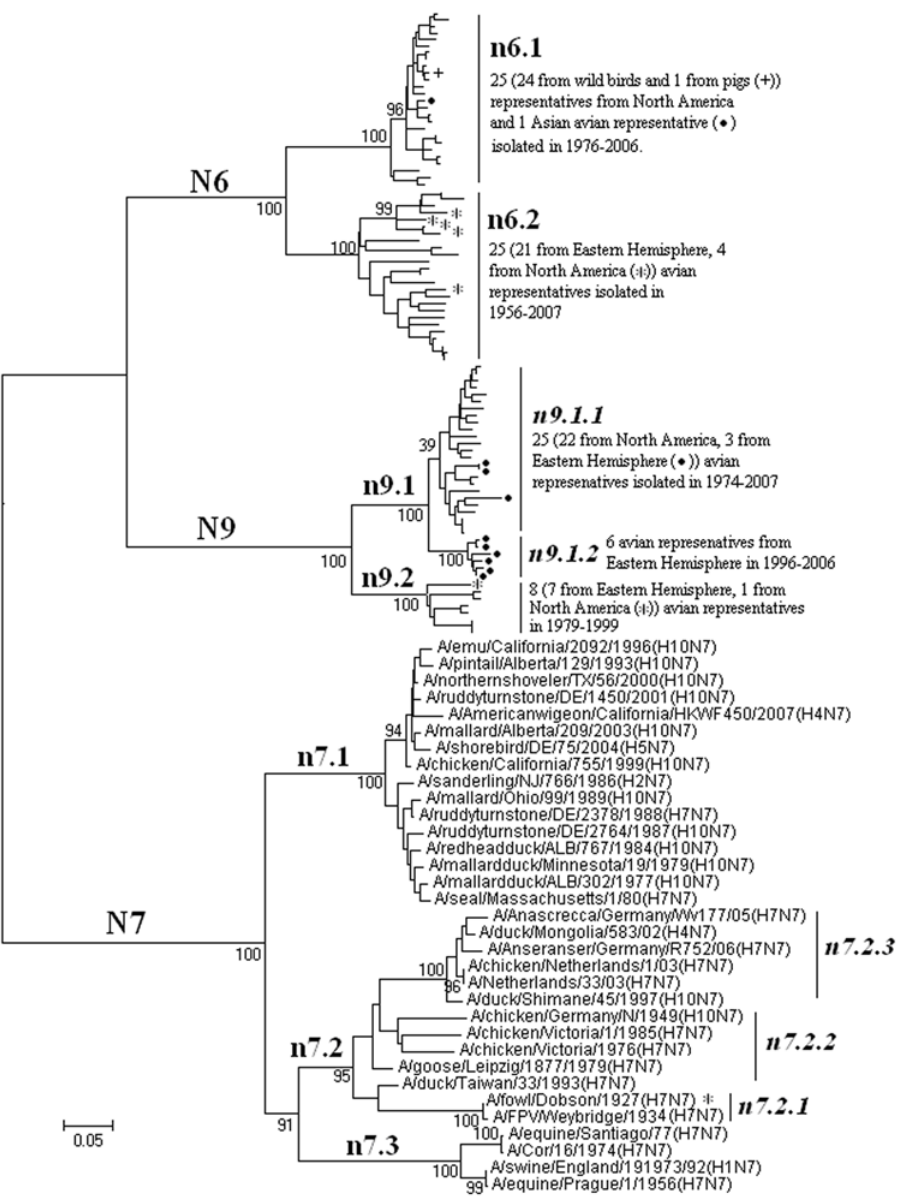
Figure 14. The panorama diversity of subtypes N6, N7 and N9 influenza viruses. Avian influenza viruses of these subtypes all could be classified into 2 lineages corresponding to the Western and Eastern Hemisphere, respectively, with some exceptions marked with ‘‘*’’ or ‘‘ N ’’. The equine N7 influenza viruses formed a separate lineage (n7.3) within subtype N7. Bootstrap values were given at relevant nodes.